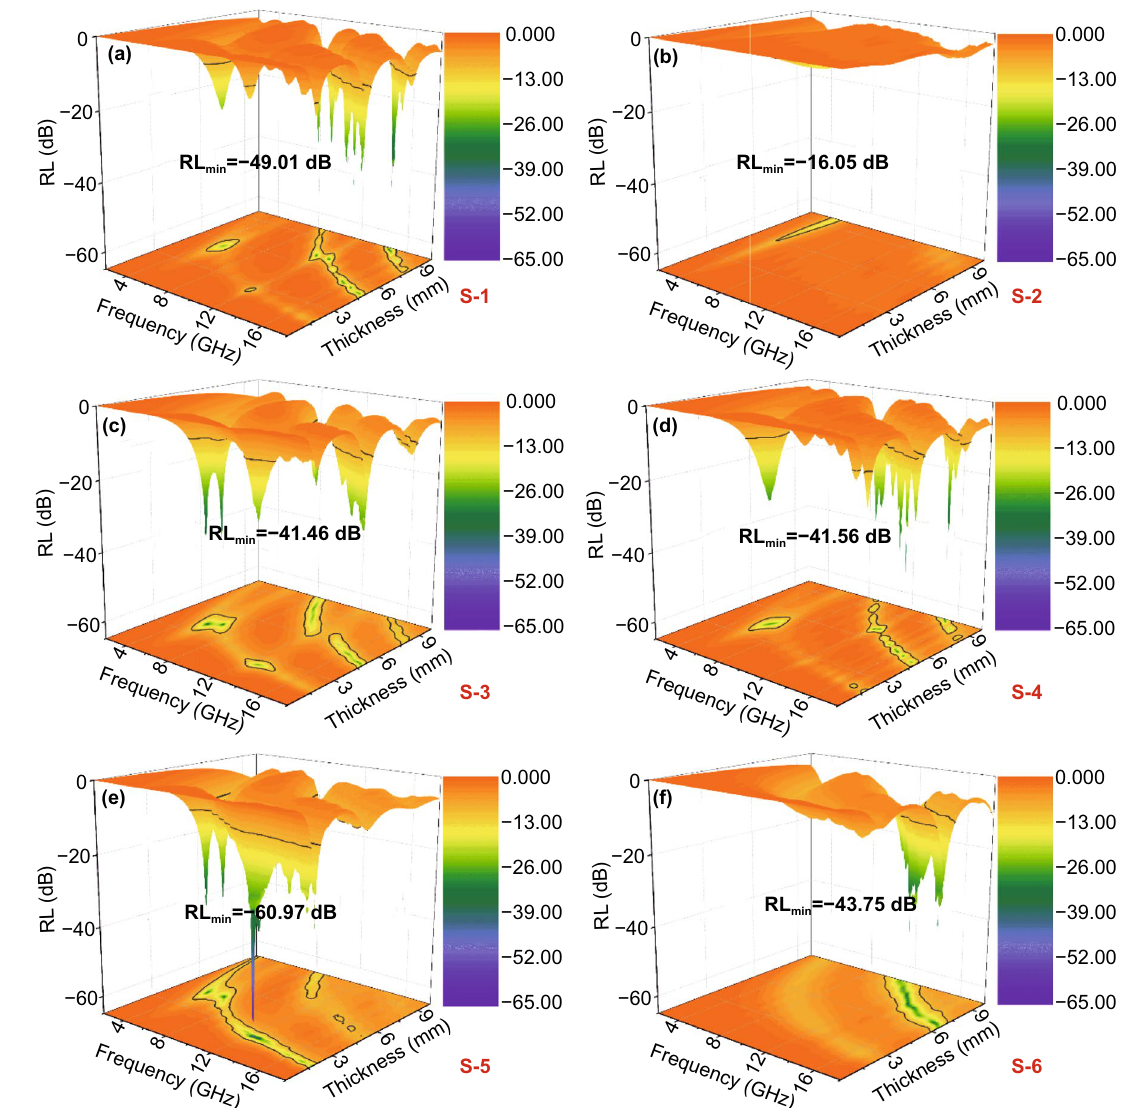
Fig. 5 Reflection loss values in the frequency of 2–18 GHz for a S-1, b S-2, c S-3, d S-4, e S-5 and f